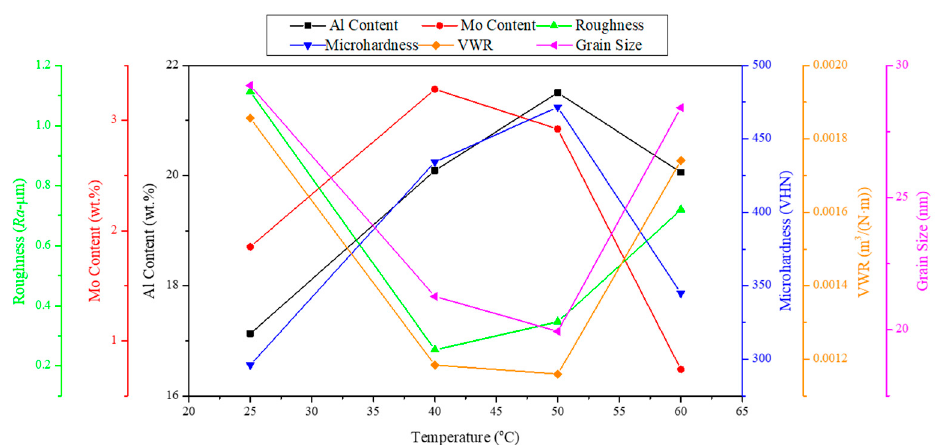
Figure 1. The effect of temperature on the grain size, chemical composition, volumetric wear rate (VWR), roughness, and microhardness properties of the coatings obtained at the current density of 30 mA/cm 2 , Al content in the solution of 5 g/L, stirring rate of 500 rpm, and different temperatures.